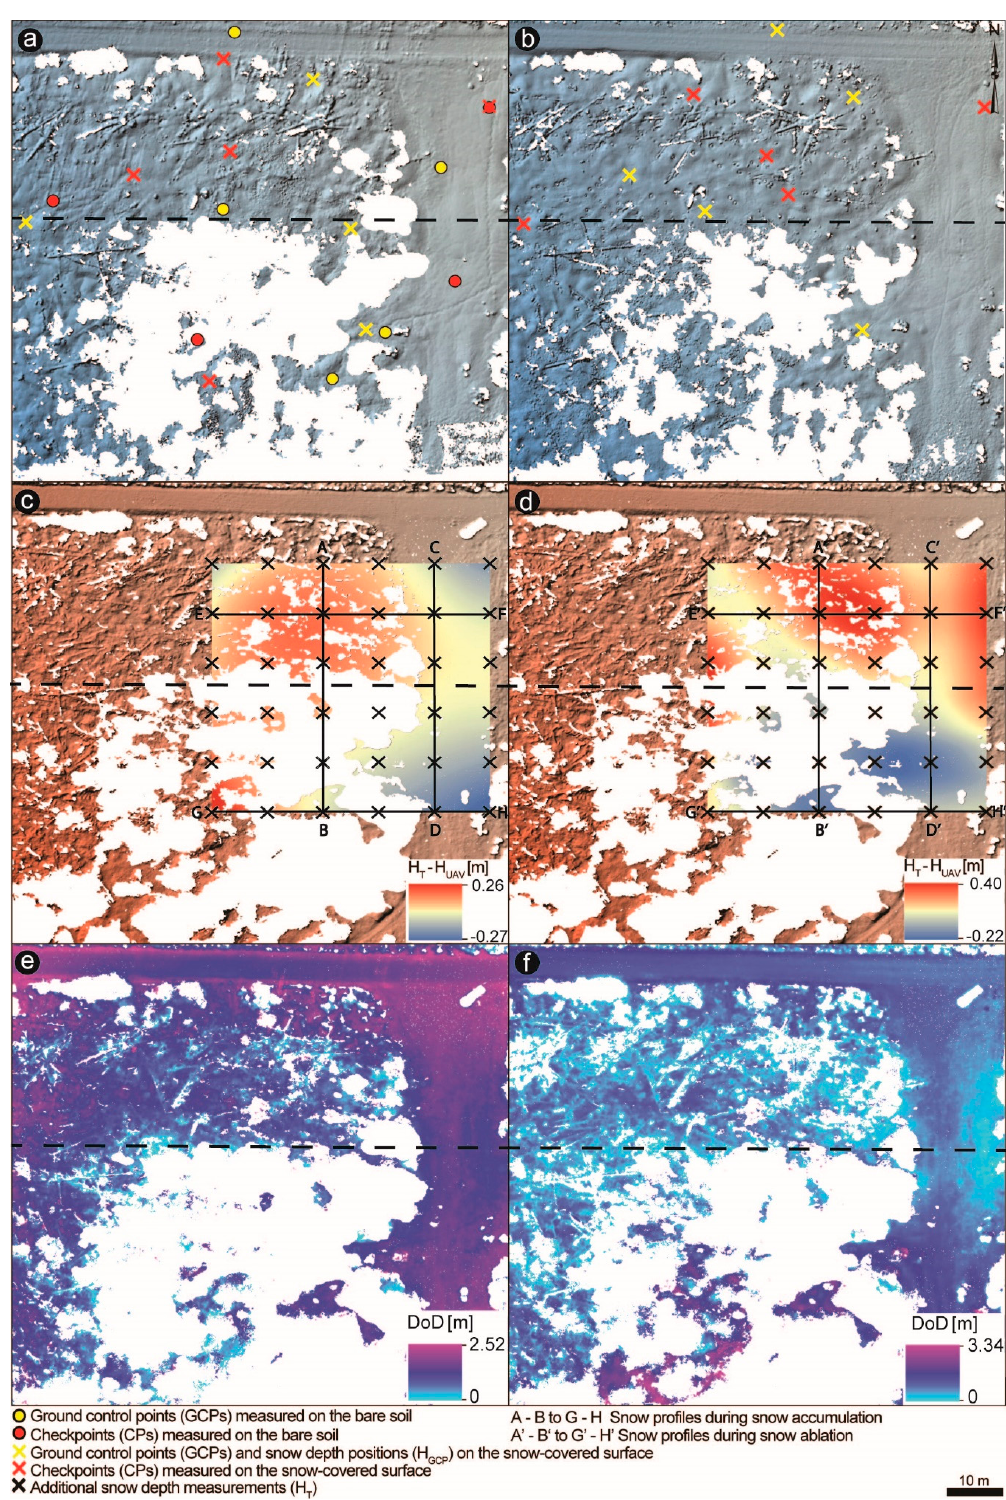
Figure 6. ( a , b ) Hillshaded snow-covered DSMs during snow accumulation and ablation, and detail surface visualization of the forest site (Ptaci Brook) with the applied ground control points (GCPs) and checkpoints (CPs). GCPs taken during snow cover served as well as reference snow depth points at the GCP positions (H GCP ; pink crosses). Overlapping snow-off and snow-on GCPs were selected in support of co-georeferencing the snow-free DSM with the snow-covered DSMs. ( c , d ) Maps of the interpolated spatial distribution of the snow height differences between the supplementary H T probes and estimated H UAV measurements underlying the bare soil hillshade. ( e , f ) DSMs of difference